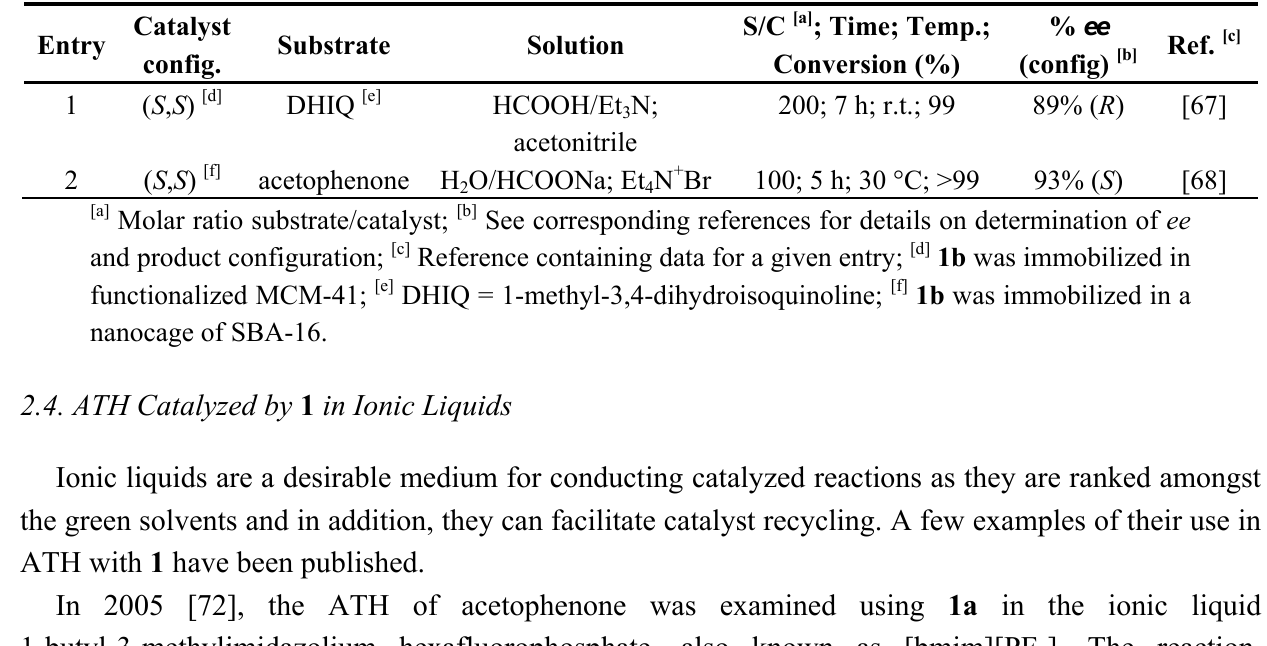
Table 3. ATH of acetophenone catalyzed by immobilized 1b